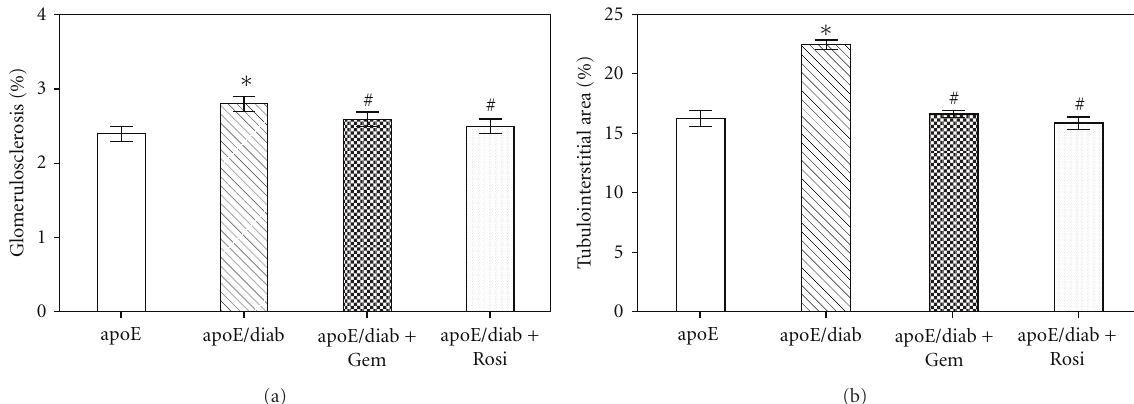
Figure 1: Treatment with PPAR agonists, gemfibrozil and rosiglitazone reduces glomerulosclerosis (a) and tubulointerstitial expansion (b) in streptozotocin diabetic apolipoprotein E knockout mice [25]. Data shows mean ± SEM; ∗ versus control P < 0 . 05, # versus diabetes P < 0 .